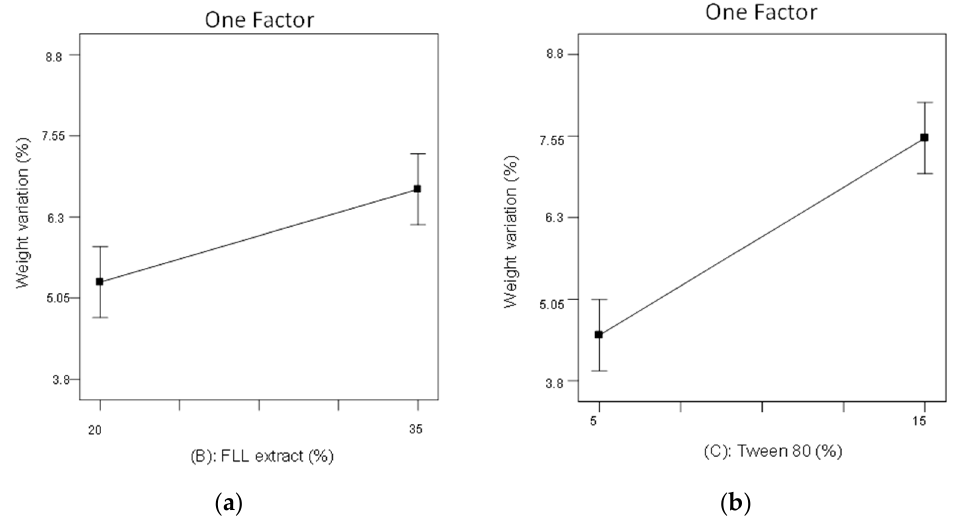
Figure 9. Using a 2 3 factorial experimental design to evaluate the effects of significant variables on weight variation ( p < 0.05). ( a ) FLL extract loading (factor B). ( b ) percentage of Tween 80 (factor C).